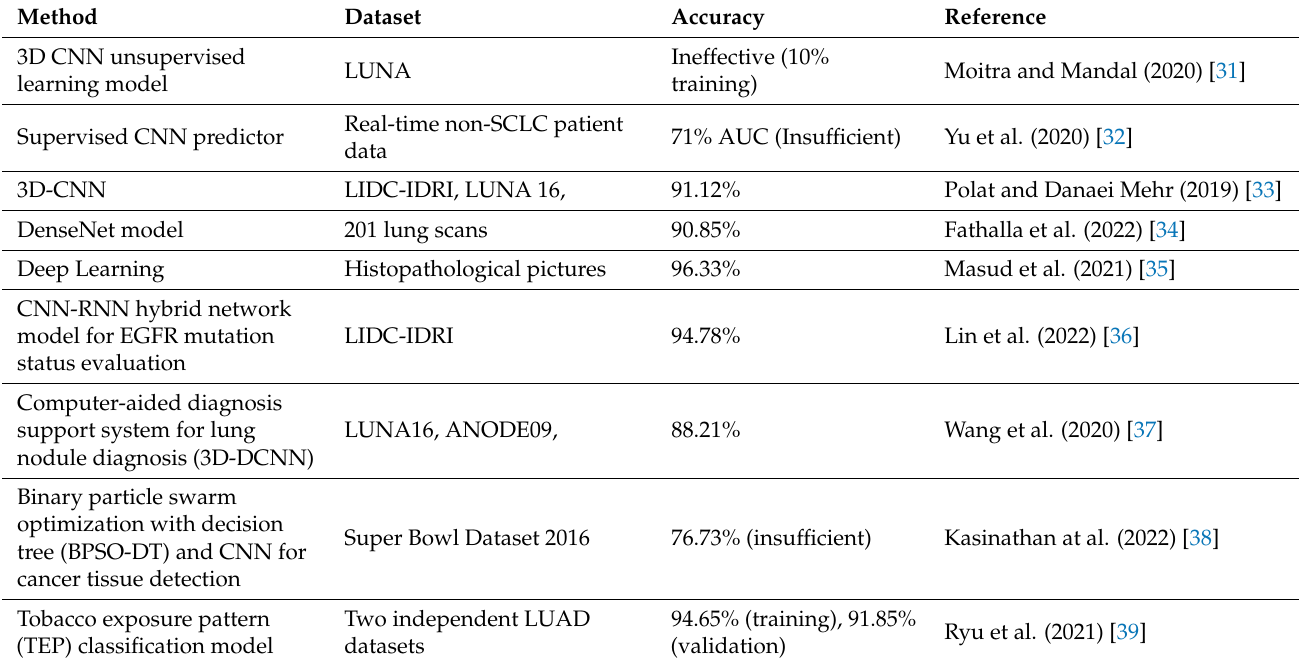
Table 1. Performance Metrics for Various Machine Learning Models in Lung Cancer Detection and